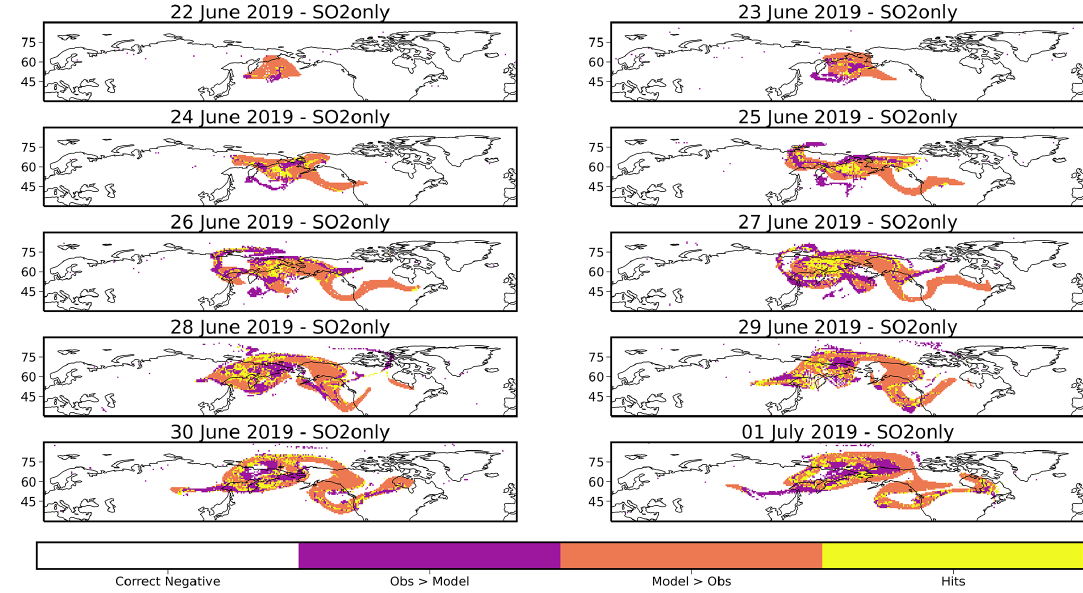
Figure 2. Contingency analysis of SO 2 plume between the OMPS-NM lower-stratospheric profile and UKESM1 SO2only for the period 22 June–1 July 2019. “Correct negative” occurs at the point where both the model and observation are below 0.3DU. “Hits” occur at the point where the modelled column SO 2 burden is within a factor of 2 of the observations at that point to allow for timing errors. “Obs > model” and “model > obs” occur when the modelled column SO 2 burden is above or below the factor of 2 limit. Table 2. Contingency analysis of SO 2 plume between the OMPS-NM lower-stratospheric profile and UKESM1 SO2only and SO2 + ash for the 20d following the eruption on 21 June 2019. “Hits” occur at the point where the modelled column SO 2 burden is within a factor of 2 of the observations at that point to allow for timing errors. “Obs > model” and “model > obs” occur when the modelled column SO 2 burden is above or below the factor of 2